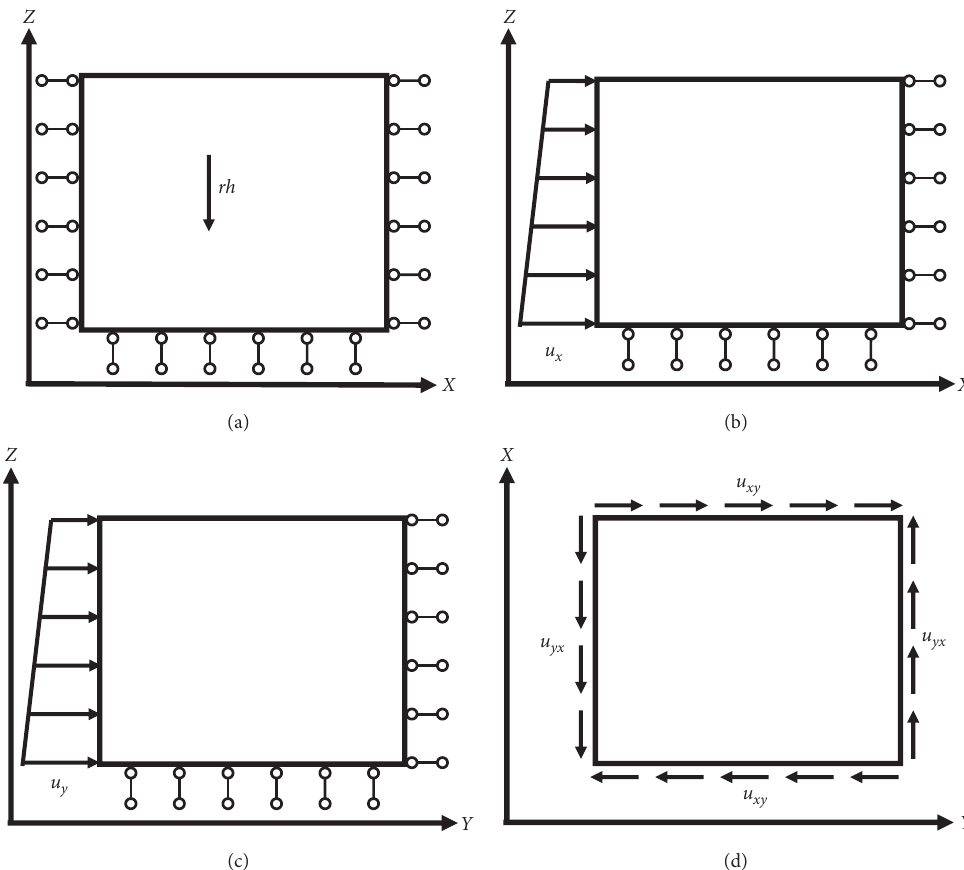
Figure 11: Schematic diagram of applied loads and boundary constraints. (a) Gravity. (b) East-West compression. (c) North-South compression. (d) Horizontal shear. Table 5: Comparison between measured and calculated in situ stress values of the tunnel in Sichuan-Tibet Railway. Measure-point